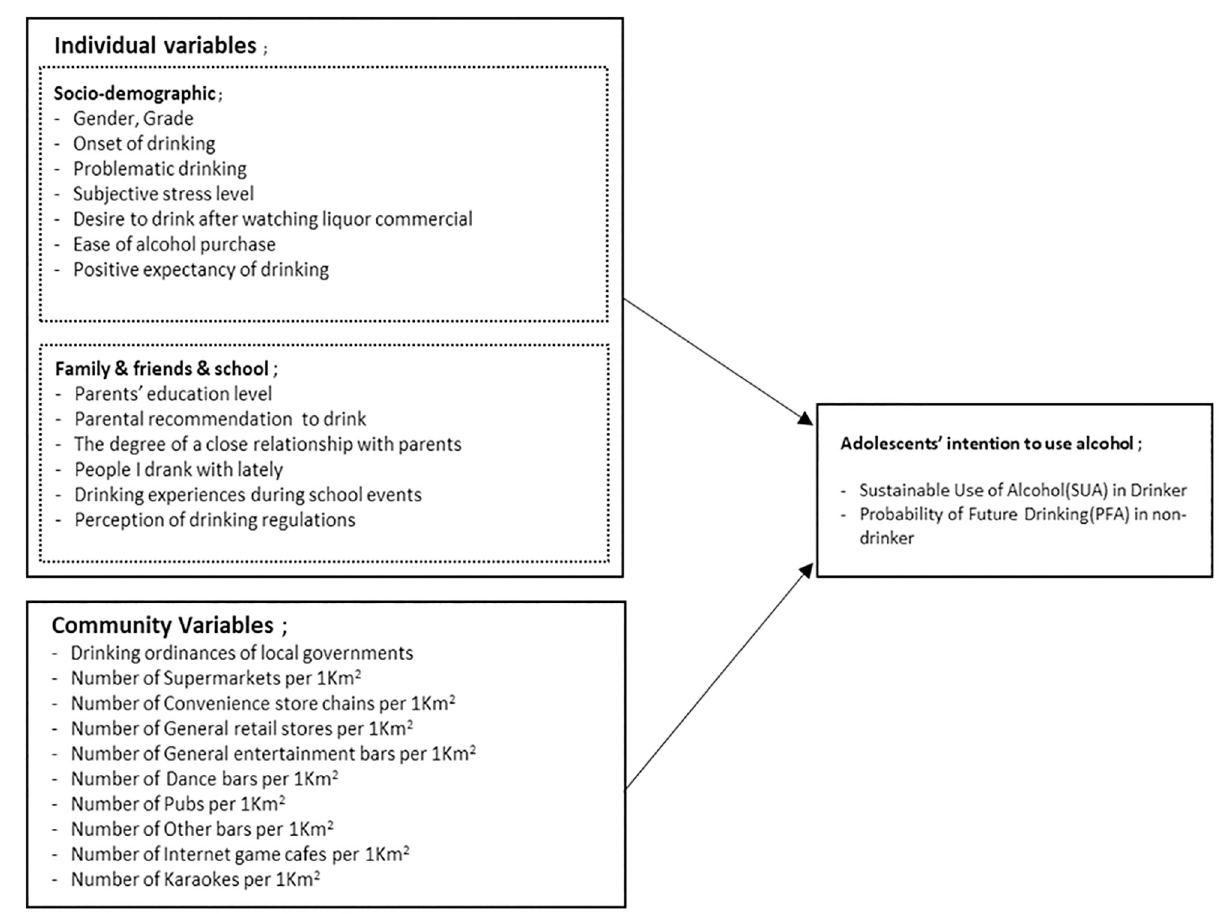
Fig 1. Framework of this